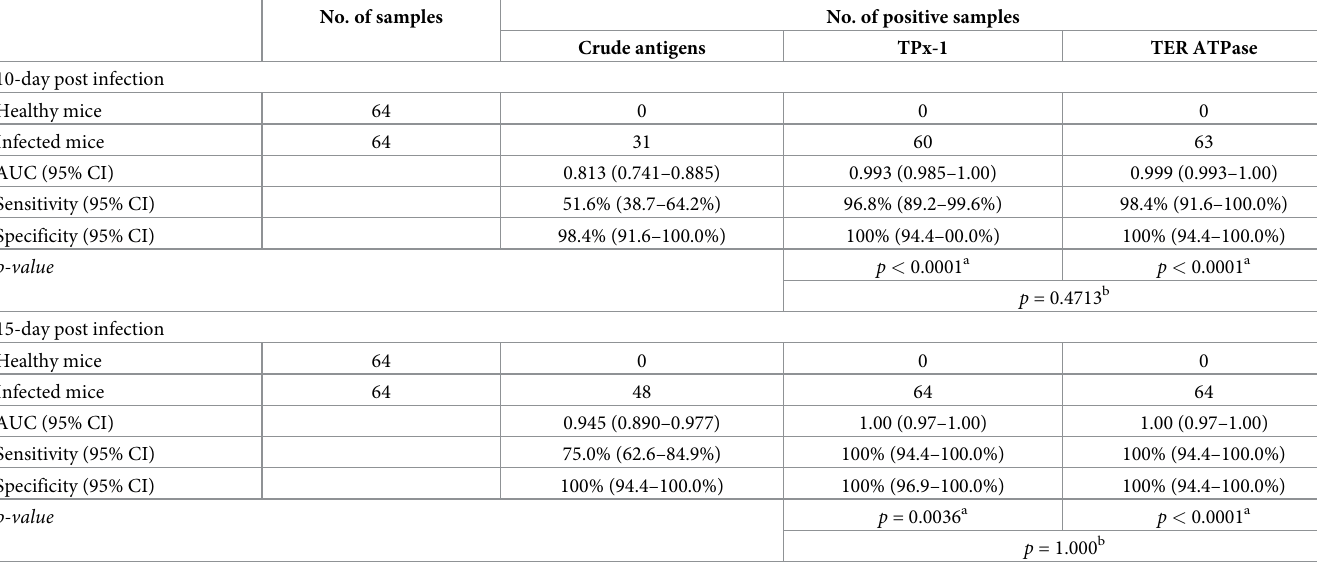
Table 3. The performance of TPx-1 and TER ATPase in the diagnosis of experimental murine echinococcosis. No. of samples